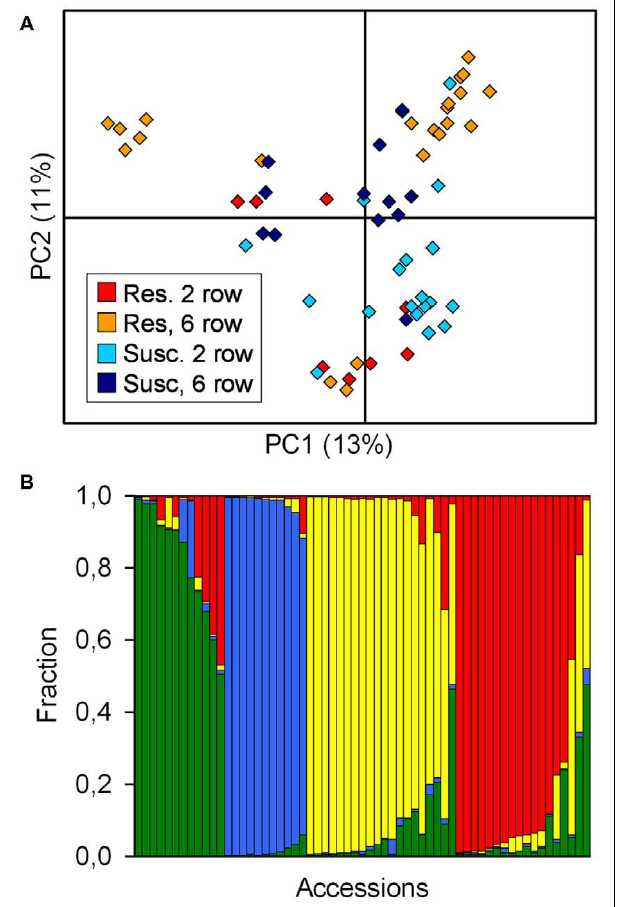
FIGURE 3 | Population stratification within the customized barley collection used for association of allelic variants with traits. (A) Principal component analysis (PCA) was performed by using 42 SSR markers. Minor SSR alleles (frequency < 0.05) were eliminated prior to analysis. For display of PC3 and 4 see FigureA3 in Appendix. (B) Population subgroups were determined as proposed by Evanno et al. (2005) by using the software STRUCTURE (Pritchard et al., 2000) and the same 42 SSR markers as for PCA. Green, accessions mostly from Near East and Central Asia; blue, accessions mostly from East Asia and USA; yellow, accessions mostly from Balkans and USA; red, accessions mostly from Europe and Ethiopia.